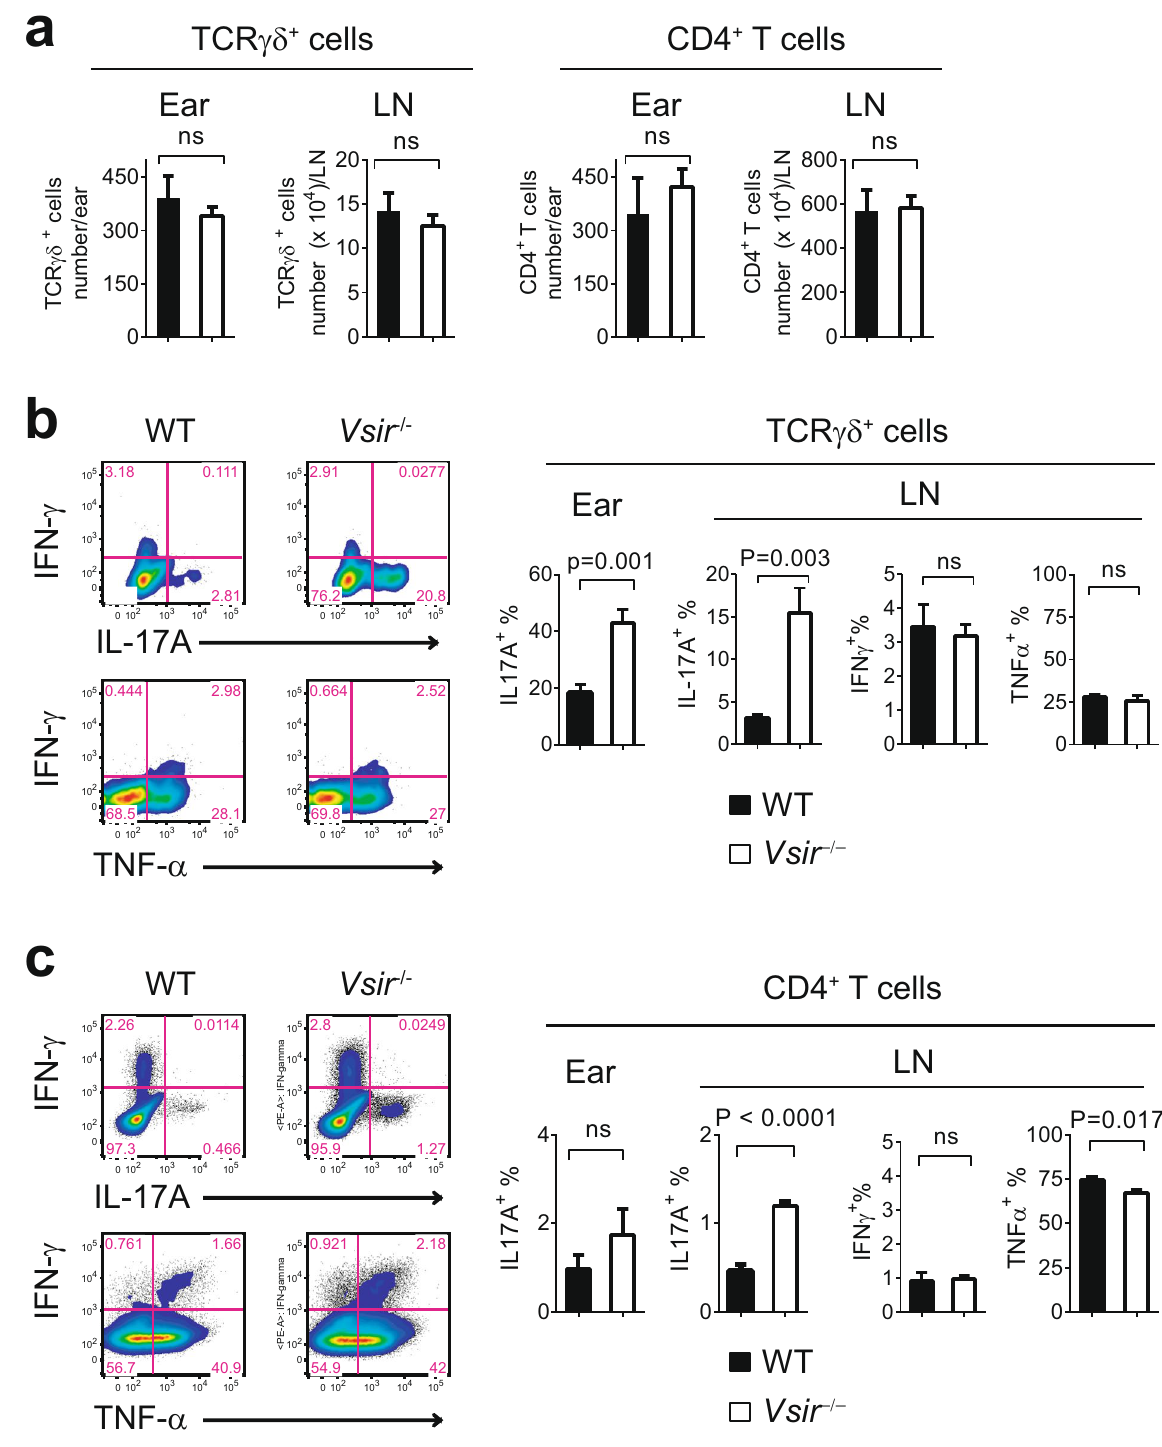
Figure 3. VISTA suppressed the production of IL-17A by γδ T cells and CD4 + Th17 cells following IMQ treatment. WT and Vsir − / − mice were topically treated on ears with 3.5% IMQ cream daily for 3 days. Cells from ear skin and draining LN were harvested and stimulated in vitro with PMA and Ionomycin. The number of γδ T cells and CD4 + T cells, and their expression of cytokines (IL-17A, IFN- γ , and TNF- α ) were examined by surface and intracellular staining, and quantified by flow cytometry. Total cell number of recovered γδ T cells and CD4 + T cells from ear tissue and draining LN are shown ( a ). The percentages of γδ T cells ( b ) and CD4 + T cells ( c ) expressing cytokines IL-17A, IFN- γ , and TNF- α were examined by flow cytometry and are shown as mean ± SEM. Representative flow plots and representative data from three independent experiments are